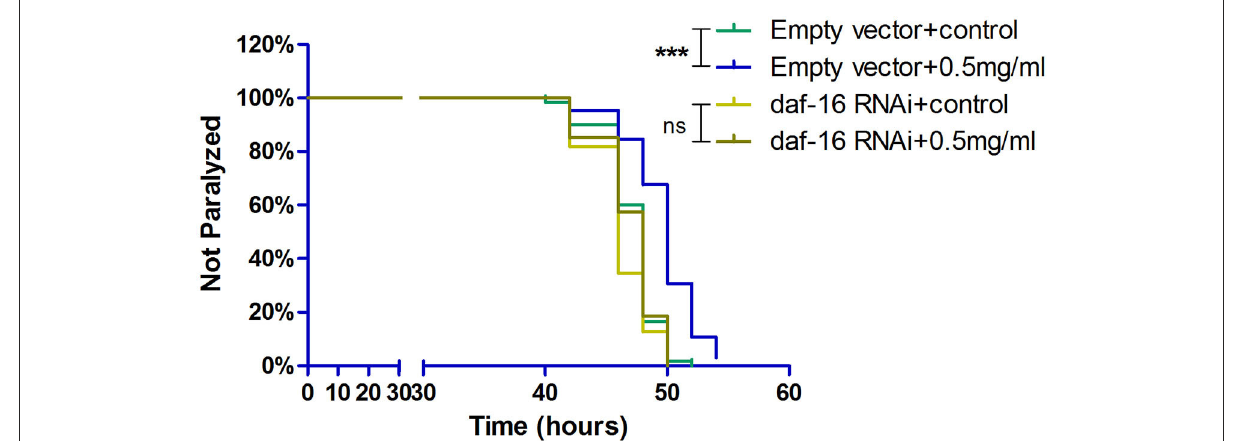
FIGURE7 Exendin-4 lost the ability to alleviate A β -induced paralysis when the daf-16 gene is knockout in transgenic C. elegans strain CL4176. DAF-16 expression was knocked down by feeding the C. elegans CL4176 with Escherichia coli strain R13H8.1 bacteria carrying daf-16 dsRNA. Curves show that the effect of Exendin-4 (0.5 mg/ml) on inhibiting the paralysis rate of C. elegans vanished after daf-16 gene knockout. (At least 50 worms were tested in each group, and the experiments were repeated independently for three